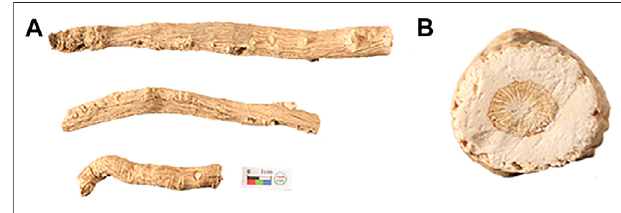
FIGURE1| Aphotographofthedriedrootof Isatisindigotica (A) andthe magni fi ed image of its transverse section (B)